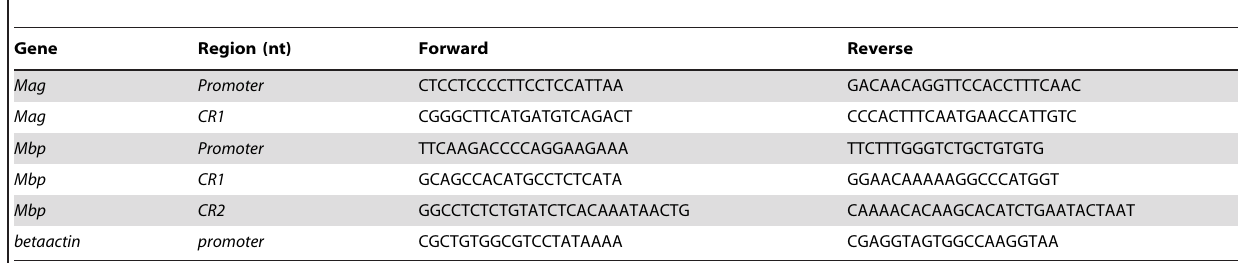
Table 4. Primers used for ChIP of rat chromatin